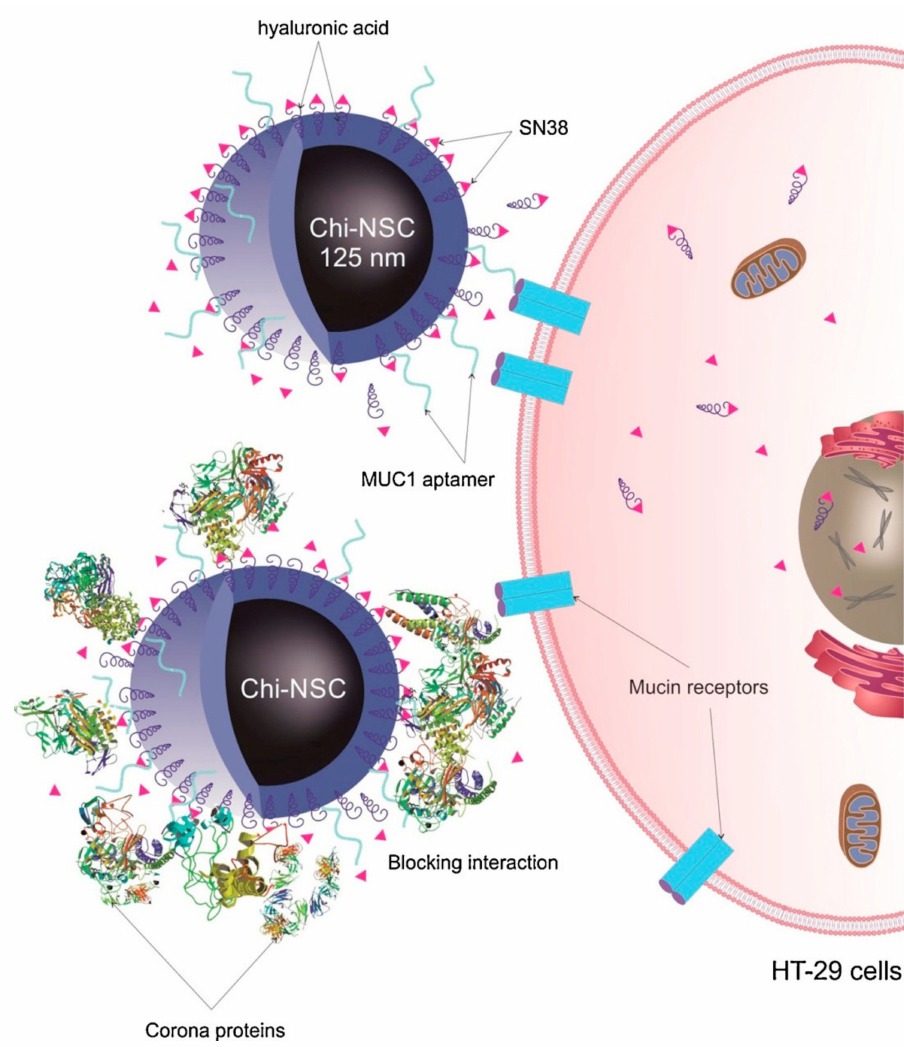
Figure 8. Scheme of interactions between bare and protein-coated MUC1 aptamer-conjugated HA / chitosan nanoparticles with MUC 1 positive HT-29 cell. Reproduced with permission from [48], Elsevier,